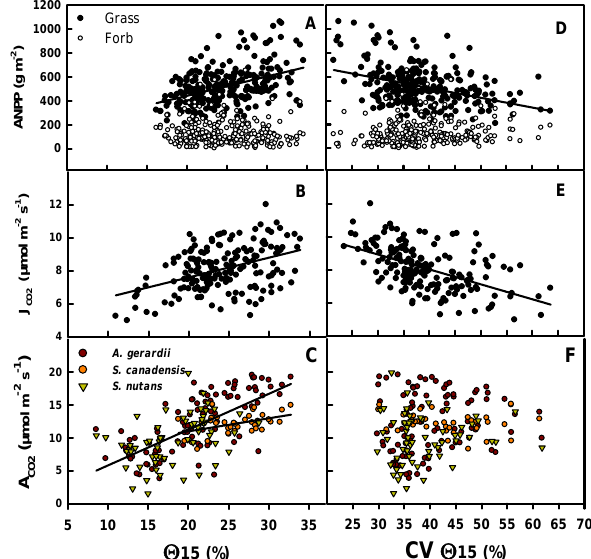
Fig. 8. Correlations of grass and forb aboveground net primary productivity (ANPP), growing season means of leaf photosynthesis ( A CO ) and soil CO 2 flux ( J CO ) with 0–15cm volumetric soil wa- 2 2 ter content ( 2 15 ) and the coefficient of variation of 2 15 (CV 2 Regression statistics are shown in Table